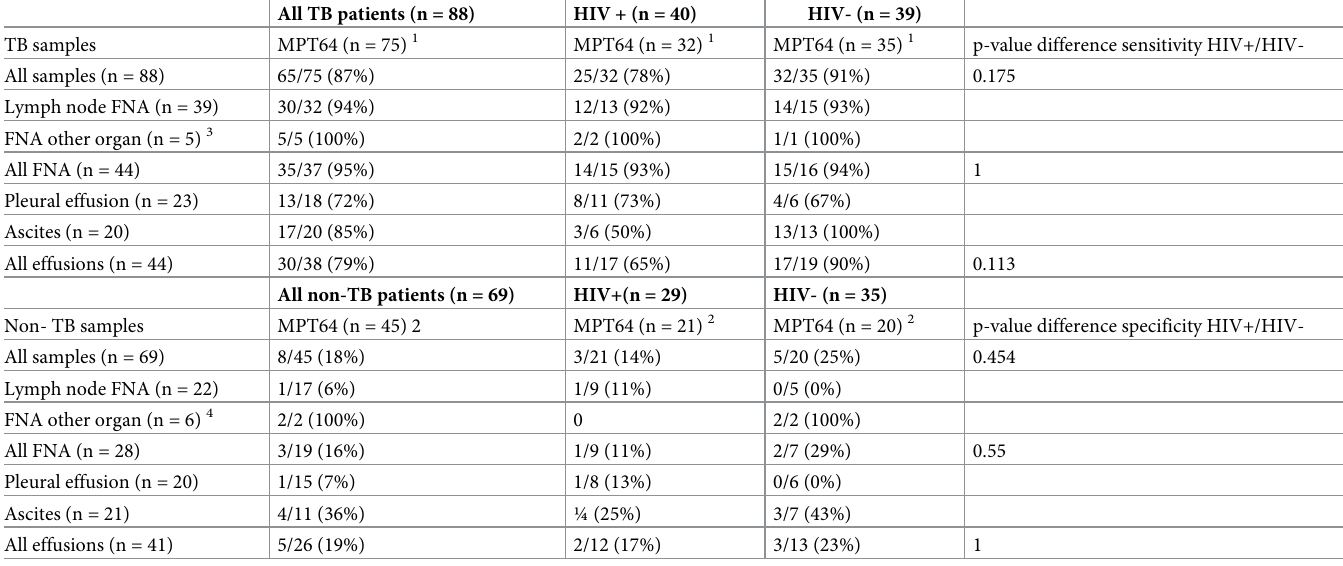
Table 2. Positive MPT64 test results across different specimens among HIV+/HIV- study participants. All TB/non-TB rows includes participants with unknown HIV status. All TB patients (n =